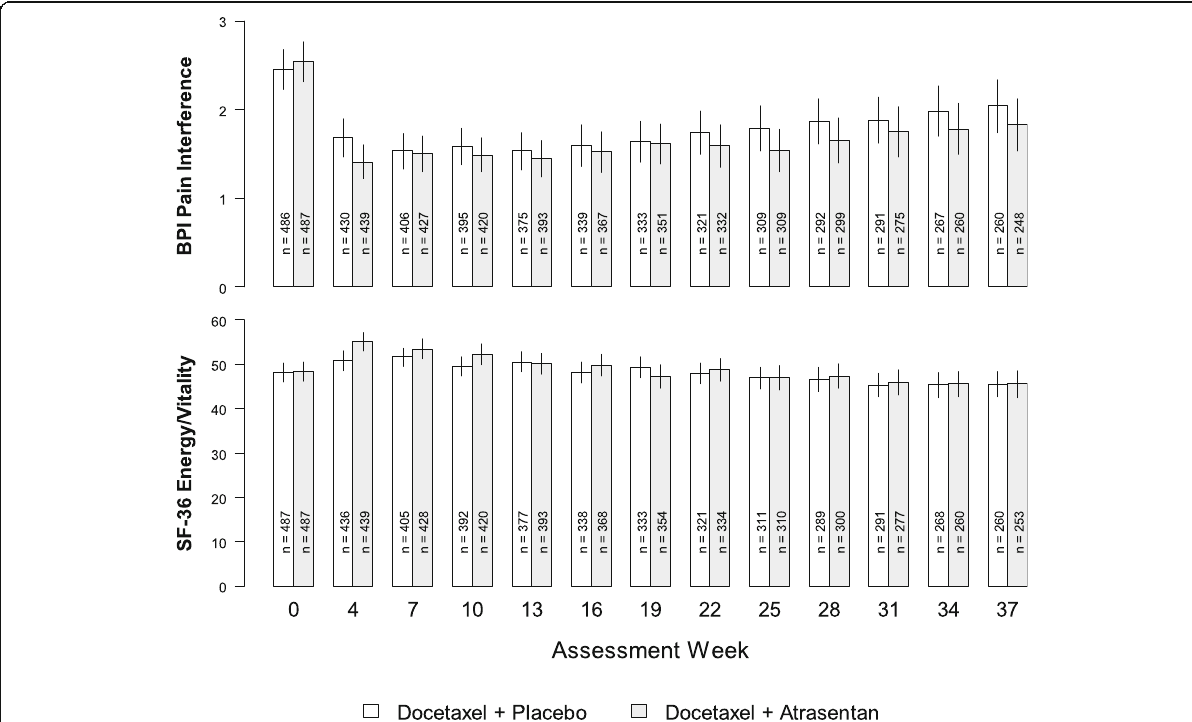
Fig. 2 Observed scores by arm over time for the BPI Pain Interference and SF-36 Energy/Vitality scales. Arm and assessment specific sample sizes are shown in the bars. Ninety-five percent confidence intervals for the observed rates are indicated by the vertical lines at the tops of the bars